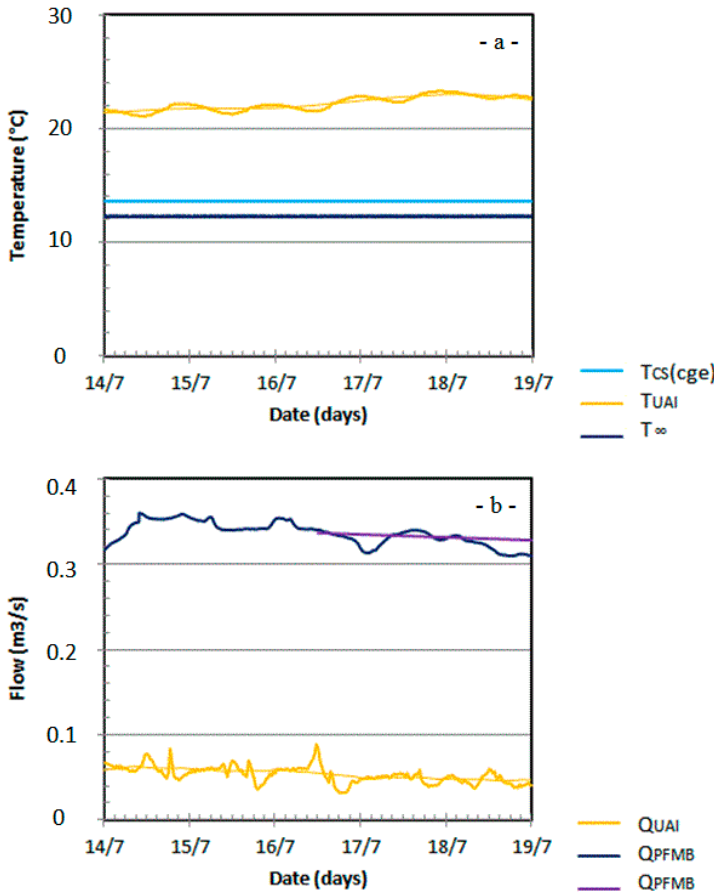
Figure 8. ( a ) Temperatures and ( b ) flows recorded or calculated during the pre-pumping period. The conduit system temperature T CS recorded in the CGS borehole and the matrix-conduit flow temperature T ∞ are almost constant over this period while the upstream allogenic intrusion temperature T UAI displays both diurnal and meteorological trends that are smoothed by the 24-h averaging. The upstream allogenic intrusion, Q UAI , also displays a diurnal behavior due to water catchments upstream of the swallow zone. Q PFM , is solved with Equation (14).